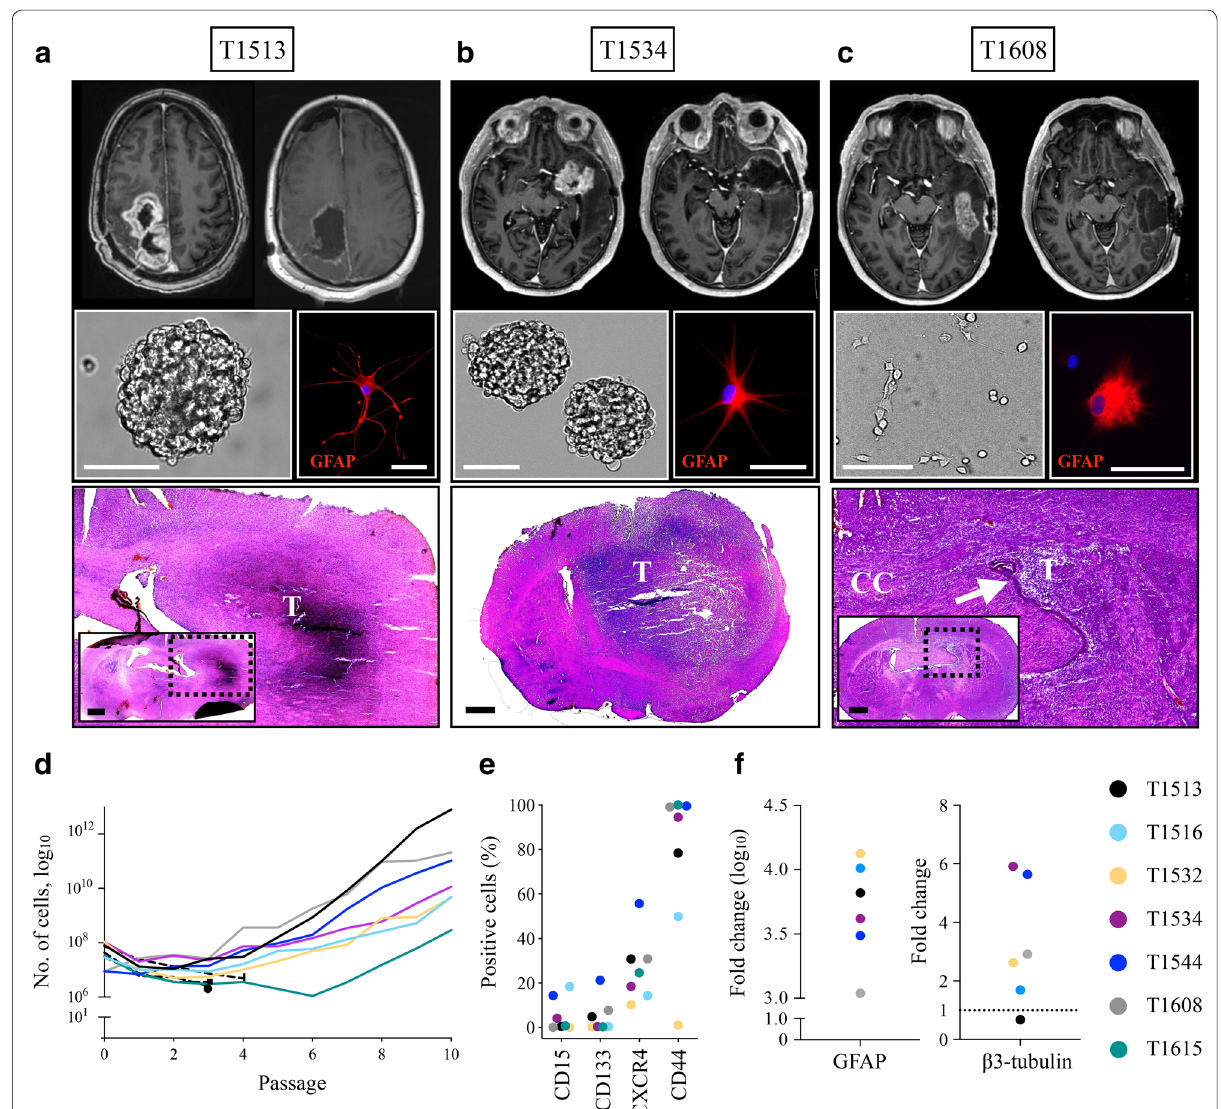
Fig. 2 Characterization of glioblastoma stem cells from recurrent GBM. a – c Pre‑ and post‑operative T1‑weighted, contrast‑enhanced MRI of three recurrent GBM with the corresponding sphere‑, cellular‑ and xenograft morphology. The individual cultures displayed extensive tumor‑to‑tumor heterogeneity in their in vitro morphology (e.g. adherent growth in T1608, various differentiation morphology) and in their induced tumor phenotype (e.g. mainly bulk formation In T1534, mainly invasive in T1608). Arrow points to compressed lateral ventricle. Xenografts stained with hematoxylin & eosin. In the recGSC cultures the tumors were harvested after 15 weeks following xenografting. d Total cell yield following serial passages revealed intertumoral variability in their capacity for cell proliferation. Dashed lines represent tumors that could not be serially expanded. e Intertumoral heterogeneity in the expression of stem cell related markers evaluated by flow cytometry. f Upon differentiation all cultures evaluated increased their expression of glial lineage marker GFAP, and all but one (T1513) increased the expression of the neuronal lineage marker